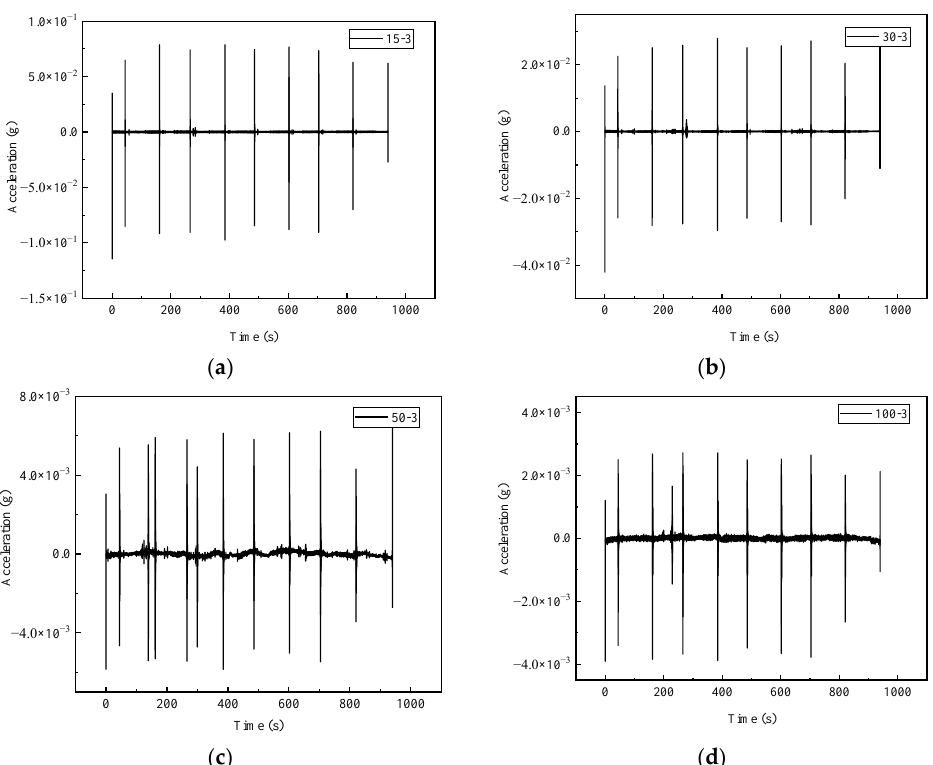
Figure 8. Acceleration time history curves in the south–north direction: ( a ) 15-3; ( b ) 30-3; ( c ) 50-3; ( d )